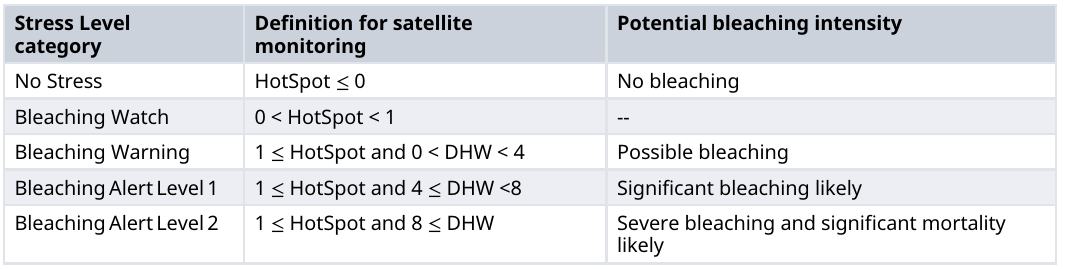
Table 2. Description of Stress Level categories used in Coral Reef Watch ’ s (CRW) satellite monitoring and modelled Four-Month Coral Bleaching Outlook products. ‘ Definition for satellite monitoring ’ column details the conditions necessary to meet each Stress Level category. The ‘ Potential bleaching intensity ’ column details the expected outcome for corals subject to each Stress